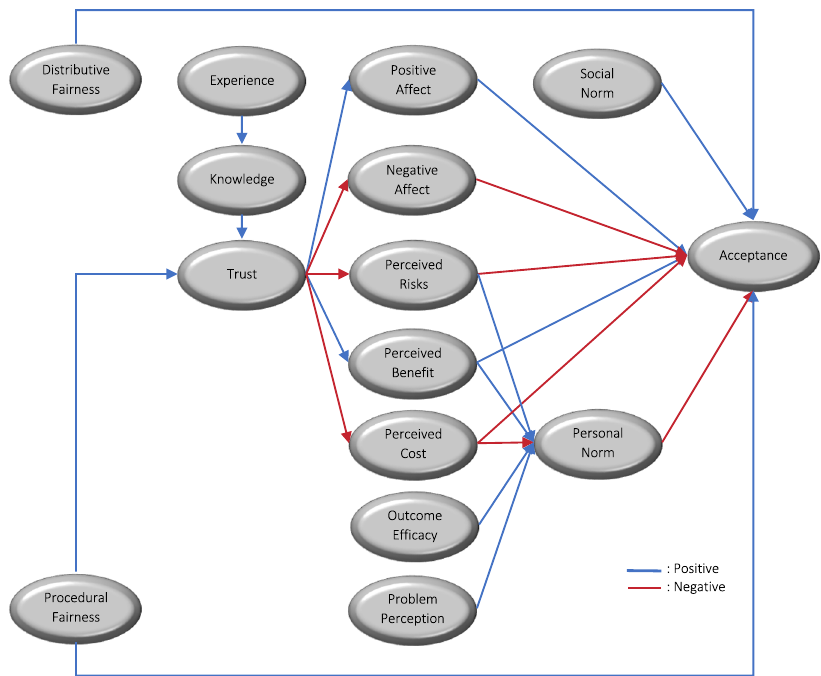
Fig. 1 The hypothesized model of the social acceptance of NBS. Arrows represent the direction of causality between the latent variables. The red and blue arrows represent negative and positive associations,